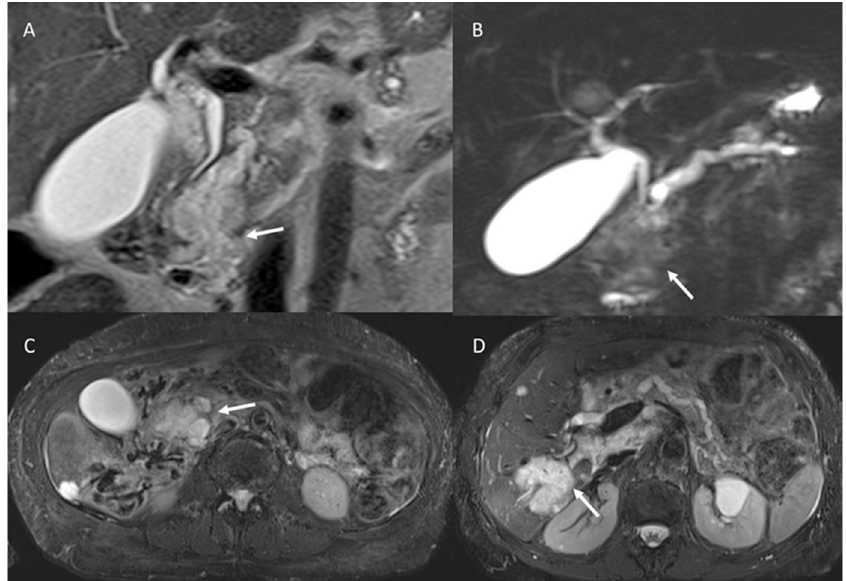
Figure 7. MRI assessment of degenerated MD-IPMN. In T2-W ( A ), MRCP ( B ) and T2-W FS ( C ) sequences the lesions appear (arrows) as a dilated MD with mucinous intraluminal component (arrow). In ( D ) (T2-W FS) arrow shows mucinous liver metastasis.